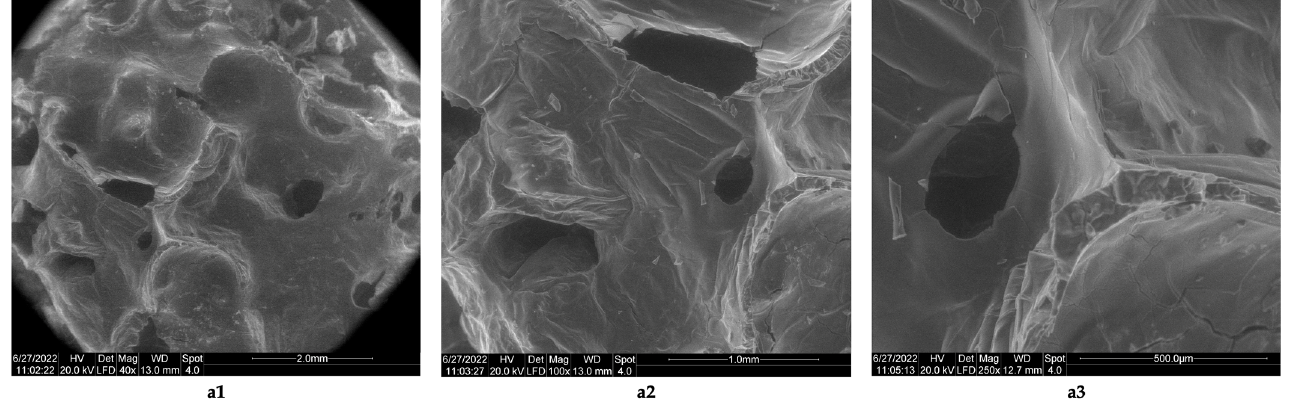
Figure 5. Morphology of collagen sponge obtained by lyophilization. ( a1 ) Total view of collagen sponge, with rare pores (magnification 40×); ( a2 ) view regarding unregulated pore geometry, most with diameters less than 1 mm (magnification 10×); ( a3 ) dimensions of the rare small pore, with diameters of 250 microns (magnification 250×).